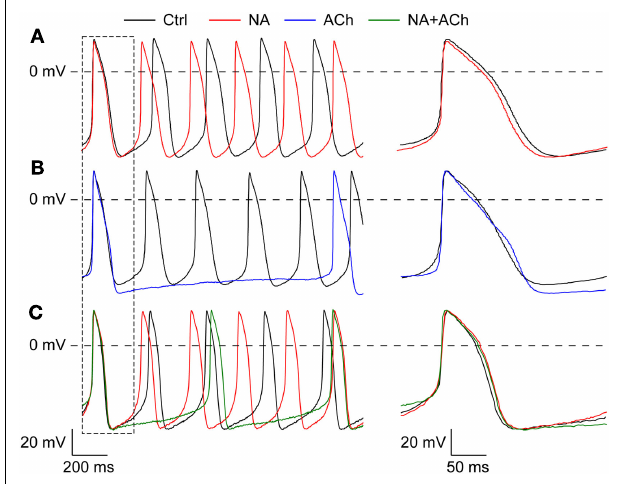
FIGURE 2 | Effects of noradrenalin, acetylcholine, or a combination of both on the action potentials of isolated rabbit SA nodal myocytes. (A) Typical action potentials of an isolated SA nodal myocyte under control conditions (“Ctrl,” black line) and in the presence of 1 μ M noradrenalin (“NA,” red line). (B) Typical action potentials of an isolated SA nodal myocyte under control conditions (“Ctrl,” black line) and in the presence of 1 μ M acetylcholine (“ACh,” blue line). (C) Typical action potentials of an isolated SA nodal myocyte under control conditions (“Ctrl,” black line), in the presence of noradrenalin (“NA,” red line), and in the presence of both noradrenalin and acetylcholine (“NA + ACh,” green line).